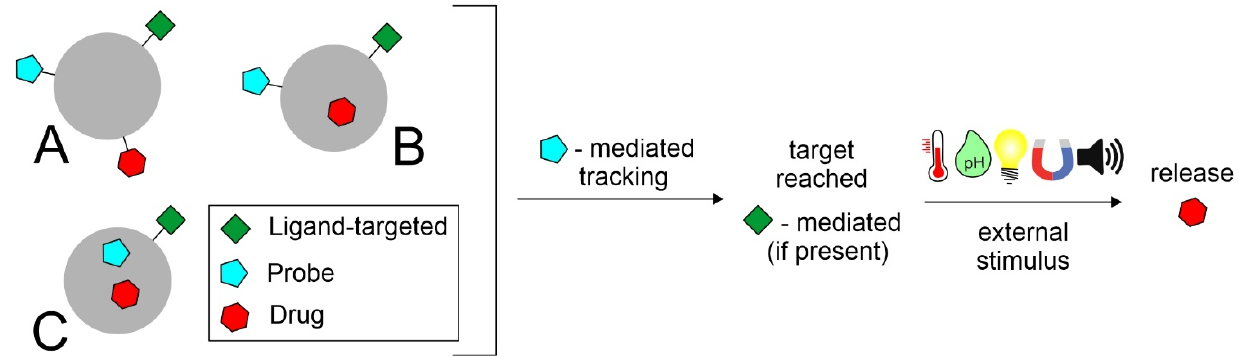
Figure 5. Prototypes of theranostic nanosystems and their mechanism of action. In figure: ( A ) label- ing of both probe and drug; ( B ) loading of drug and labeling of probe; ( C ) co-loading of drug and probe.